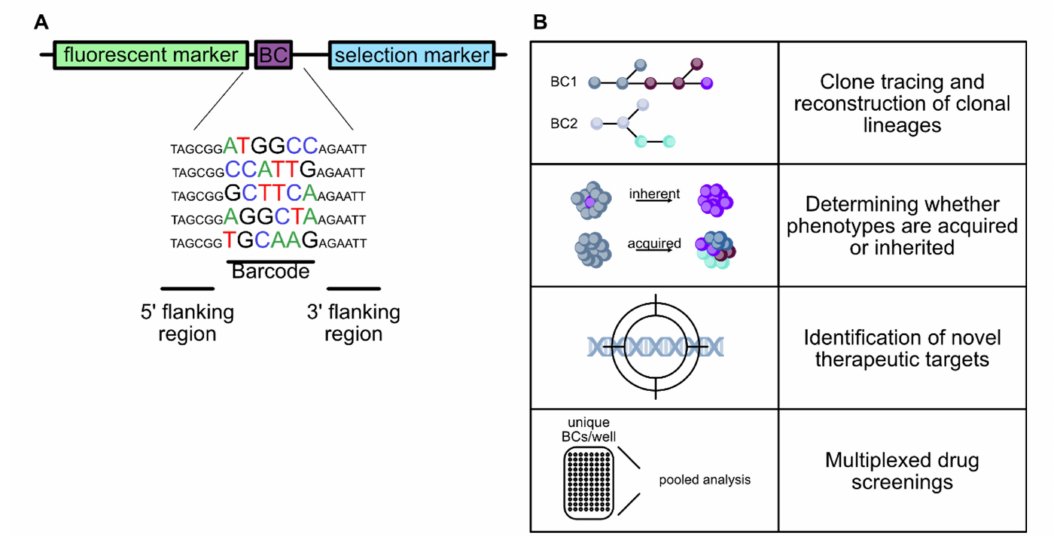
Figure 2. Molecular barcoding in cancer research. ( A ) Schematic of a barcoding construct exemplary with a short, six- nucleotide, random barcode sequence (BC). Often, fluorescent proteins such as GFP are also part of the construct to